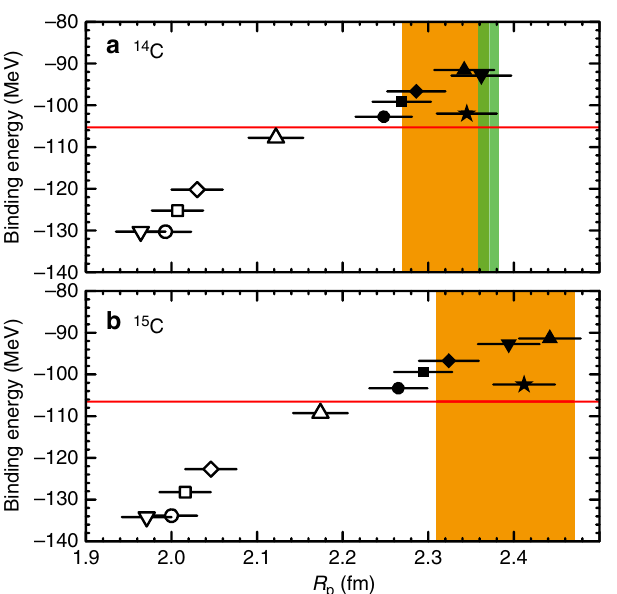
Fig. 5 Shell evolution. Empirical one-proton addition ( ϵ þ p ) and removal ( ϵ (cid:2) p ) energies (horizontal bars) for a carbon, and b oxygen isotopes deduced from one-proton separation energies and the excitation energies of the lowest 3/2 − states in the odd – even nitrogen isotopes. The dotted bars indicate the adopted values for the observed excited states in 19,21 N, which have been tentatively assigned as 3/2 − 57 . Other experimental data are taken from refs. 31,58,59 . The blue symbols are the shell model calculations using the YSOX interactions 60 . Results of the CC calculations with and without 3NFs are shown by the red-solid and red-dashed lines,